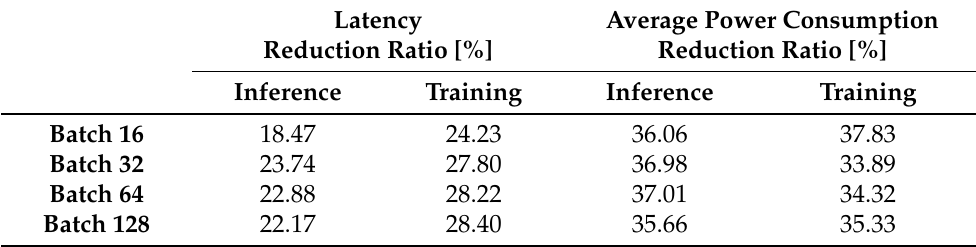
Figure 13. The experiments about average power consumption of PSMs per batch size. Table 2. The reduction ratio of the latency and average power consumption performed by the proposed method compared to by the